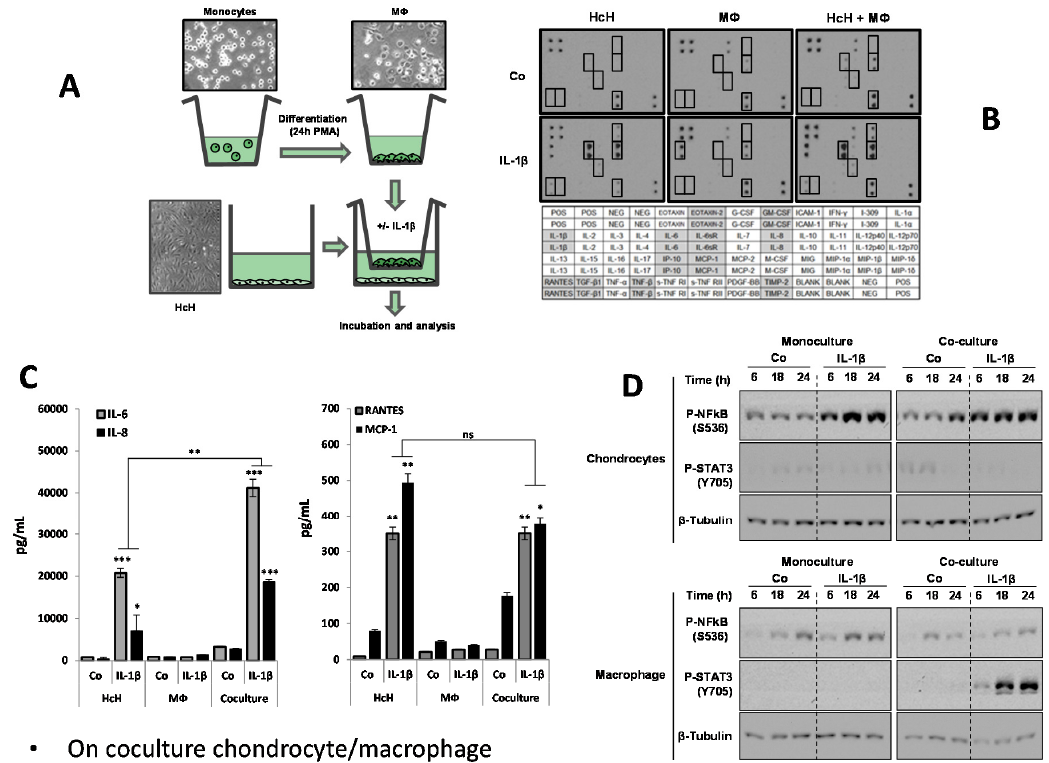
Figure 1. Characterization of inflammation in chondrocyte/macrophage coculture model. ( A ) Scheme of coculture model device and morphology of the grown cells as seen by contrast phase optical microscopy. HcH: Human chondrocytes. M Φ : Macrophages; ( B ) Representation of antibody ‐ array screening of cytokines, 24 h after IL ‐ 1 β treatment (IL ‐ 1 β ) or not (Co) on primary human chondrocytes